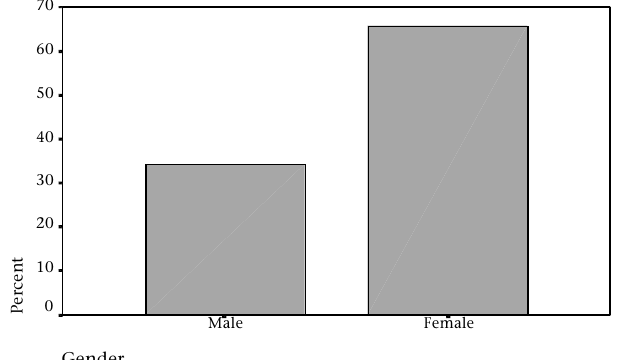
Figure 3: Gender breakdown of SETA Managers